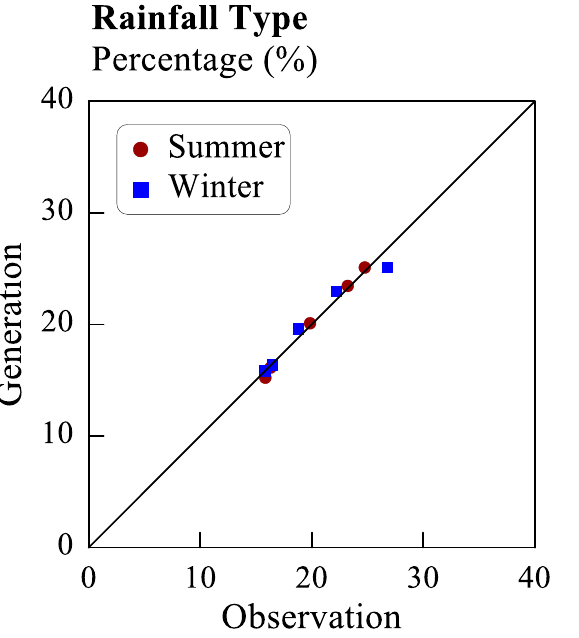
Figure 14. Comparison of the observed and generated numbers of rainfall events for different rainfall types.